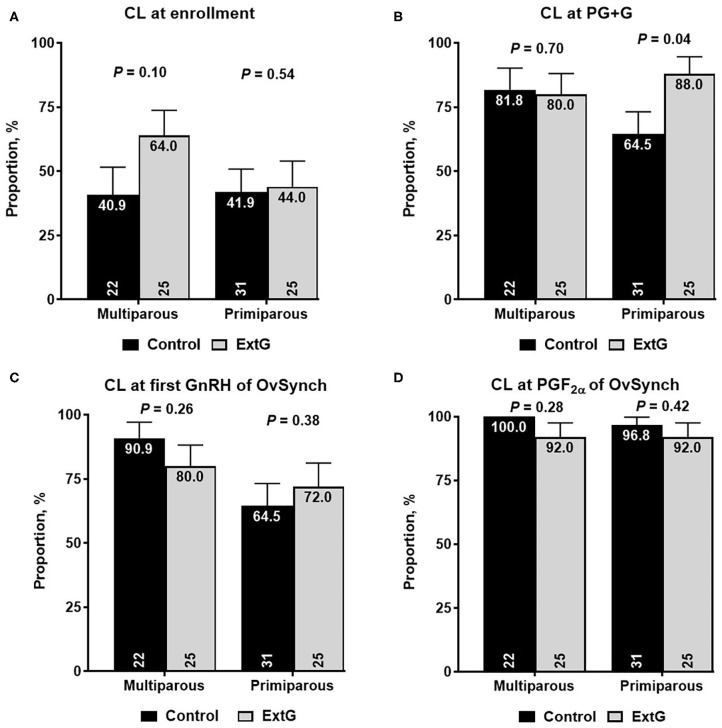
Bar graph illustrating the proportion of cows with corpus luteum (CL) (A) at enrollment, (B) at simultaneous PGF2α and GnRH (PG+G), (C) at first GnRH of OvSynch, and (D) at PGF2α of OvSynch according to treatment (Control vs. ExtG) in multiparous and primiparous cows. The proportion is listed on the top, whereas the number of cows per treatment is at the bottom. Error bars represent the standard error of the mean.